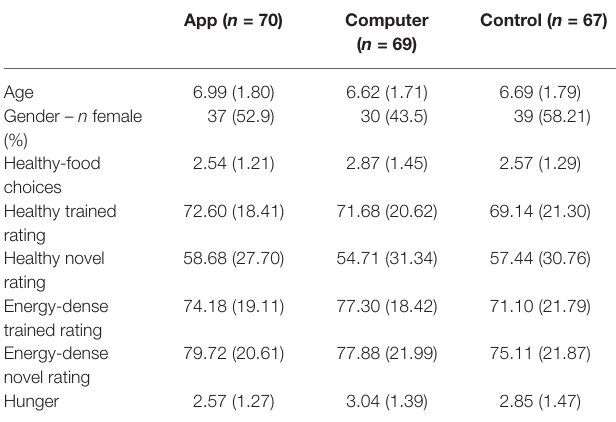
TABLE 3 | Group demographic characteristics and baseline outcome